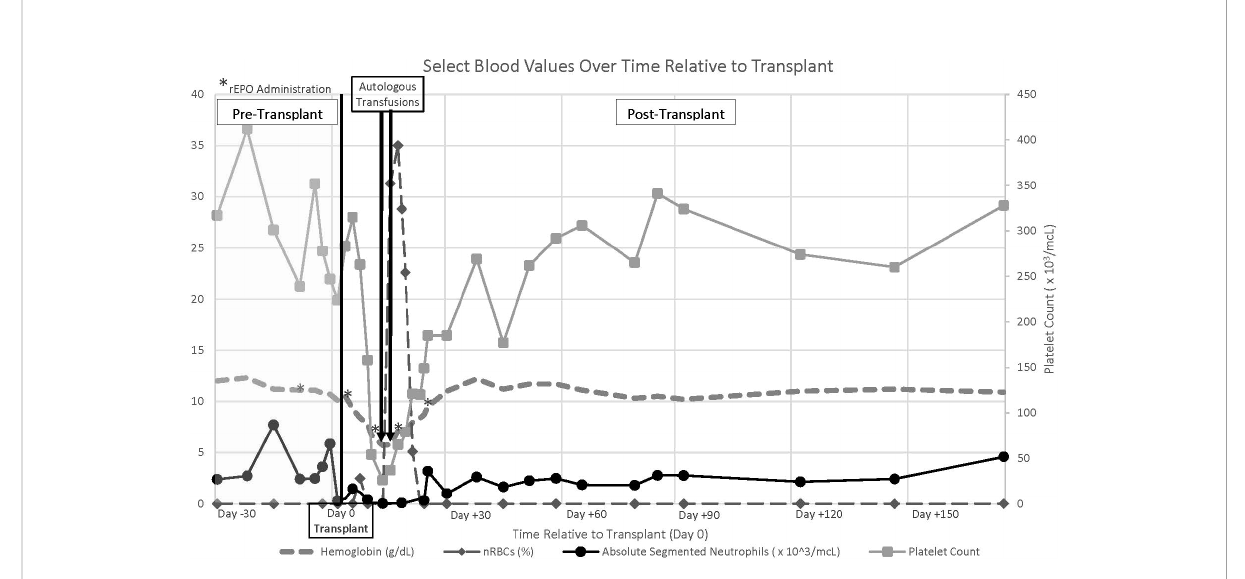
FIGURE 2 Select blood count values pre and post-transplant relative to Day